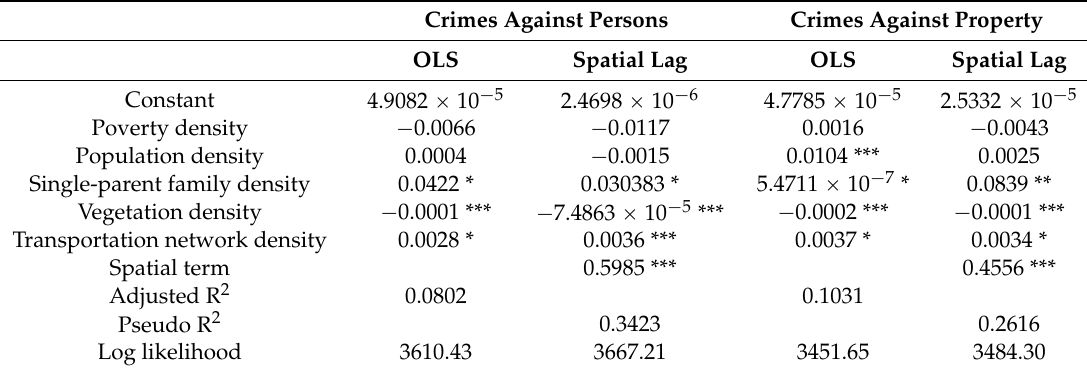
Table 4. Spatial regression results for crimes against persons and crimes against